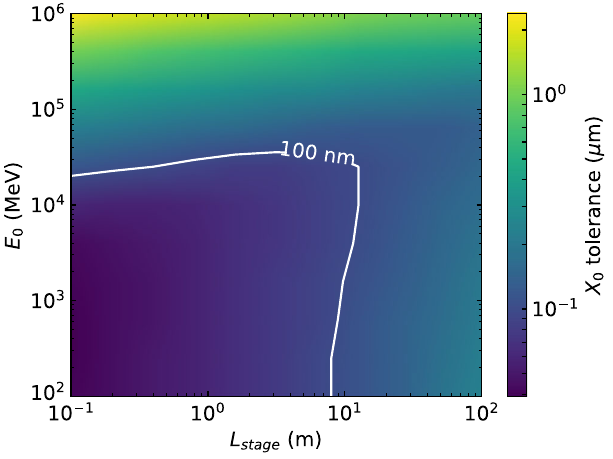
FIG. 13. Model projection for the tolerance on absolute beam displacement assuming the final beam emittance is ϵ xf ¼ 0 . 01 mm mrad as a function of the stage length and initial energy. The absolute energy spread is constant to 1 GeV, and the initial beam emittance is ϵ x 0 ¼ 10 − 3 mm mrad. Following the scalings in the linear regimefor a 0 ≲ 1 from Ref. [2], the energygain per stage ¼ 1 m corresponds to a chain of 70 LPAs is ∝ L 2 = 3 , so that L stage stage ¼ 100 m corresponds to a chain of four and L stage